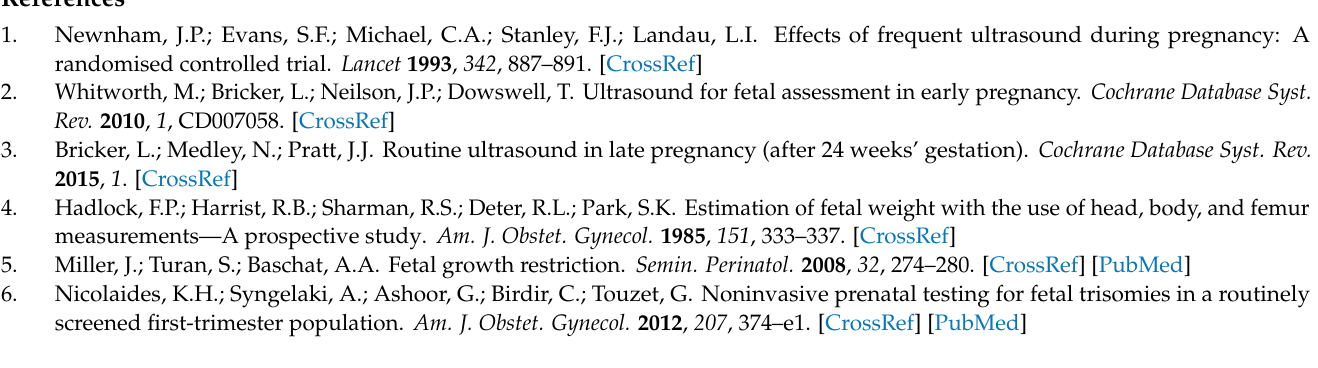
Table S1: GANs training configuration for Trans-thalamic (TTA) and Trans-ventricular (TRV)